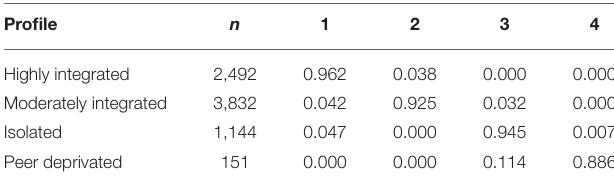
TABLE 4 | Average latent class probabilities for most likely latent class membership (row) by latent class